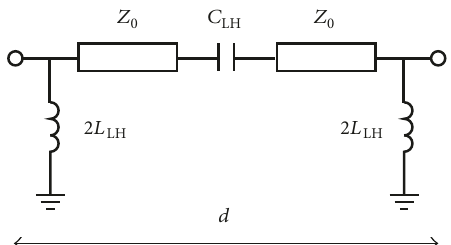
Figure 1: Equivalent circuit model for the ideal CRLH-TL unit cell.